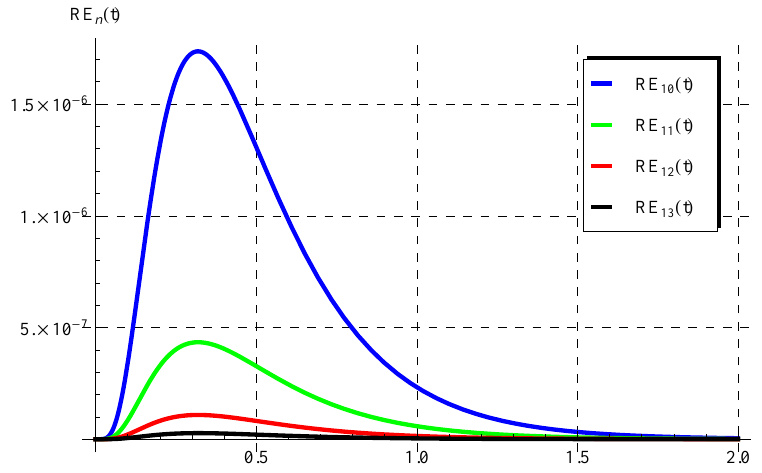
Figure 8. The residuals RE r ( t ) , r = 10,11,12,13 in Equation (76) at λ = 1, a = − 2, b = 1, and c = 2.